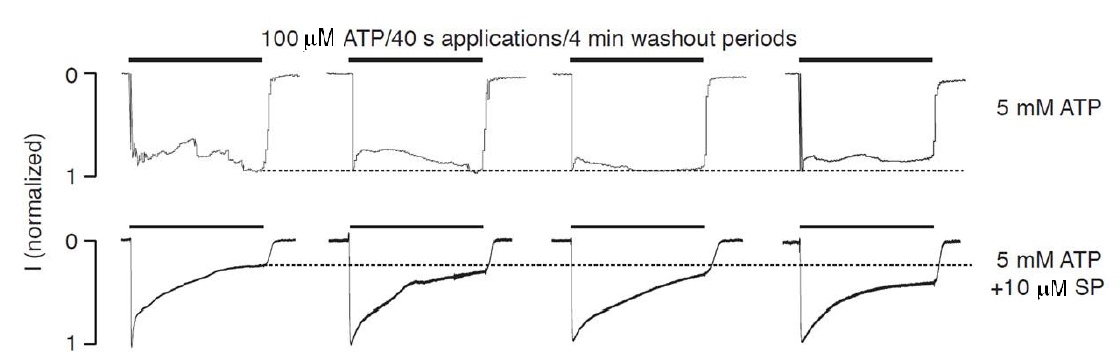
Figure 5. Potential role of protein kinases in the intracellular ATP effects on receptor desensitization; whole-cell recordings in HEK293 cells expressing P2X2aR at a holding potential of − 60 mV. ( Top panels ) The loss of receptor desensitization in cells filled with 5 mM ATP-containing medium; ( Bottom panels ) Restoration of receptor desensitization in cells filled with a medium containing 5 mM ATP plus 10 µ M staurosporine (SP). Notice the lack of UDD in the presence of SP. In both experiments, the cells were dialyzed for 7 min before the extracellular ATP was applied. The horizontal dotted lines indicate the peak amplitude of the current at the end of the first pulse of extracellular